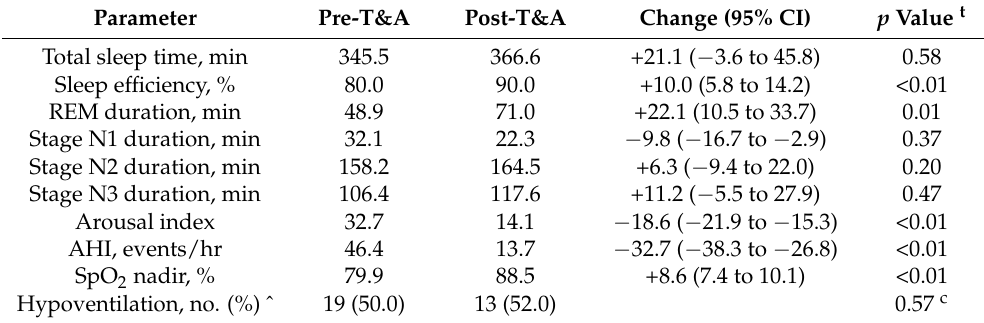
Table 4. Changes in PSG parameters for children with severe OSA following T&A (n = 34)